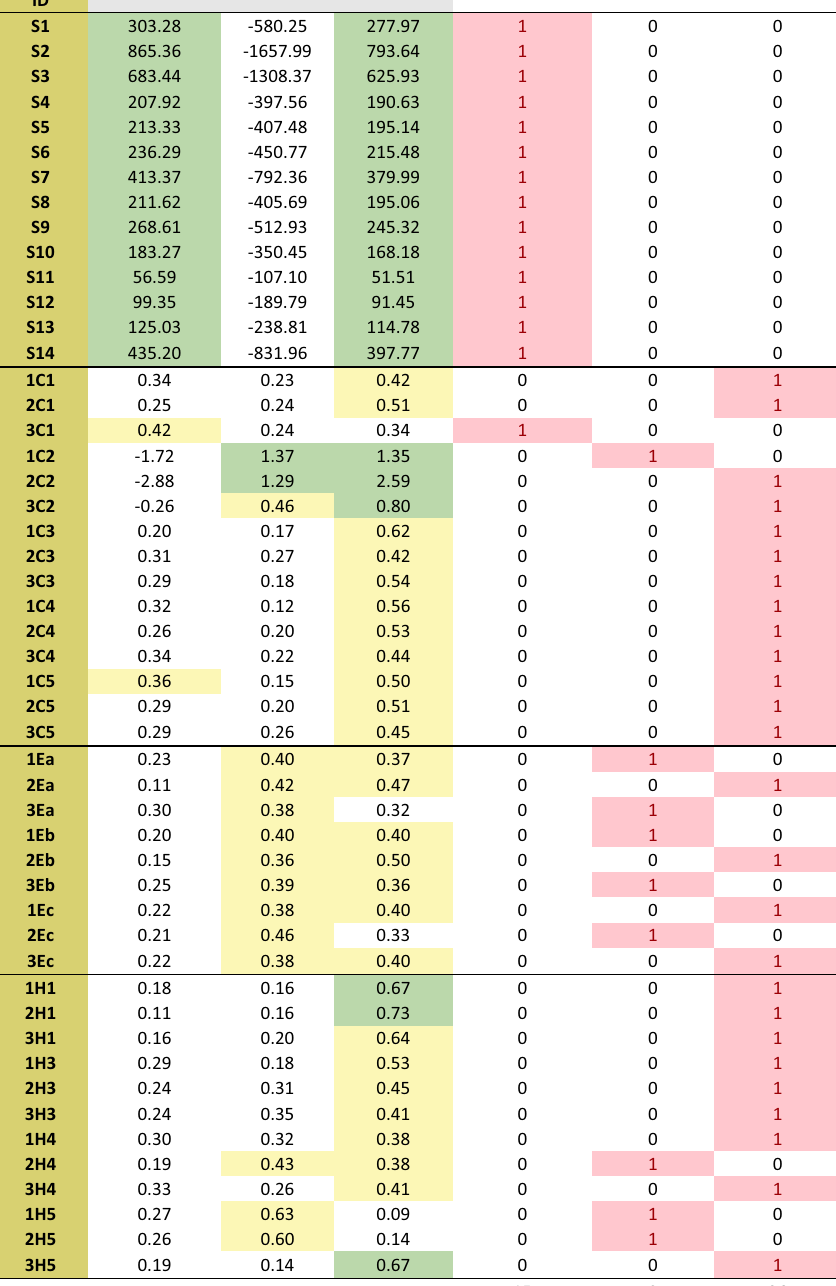
(Table S6), namely a work on an industrial port in the Southern Kaohsiung Harbor of Taiwan 65 and a work on three Mediterranean ports: Cagliari (Italy), El Kantaoui (Tunisia), and Heraklion (Greece) 66. The validation set was composed by 50 samples: 14 samples (S1–S14) collected in the Southern Kaohsiung Harbor, a port extensively polluted by industrial wastewater discharges (1C1–3C5); 9 samples from El Kantaoui port, a quite recent small artificial marina (0.04 km 2 ), located on the Eastern Tunisian coast within an interna- tional touristic center and surrounded by a small permanent population (1Ea–3Ec); 12 samples from Heraklion,